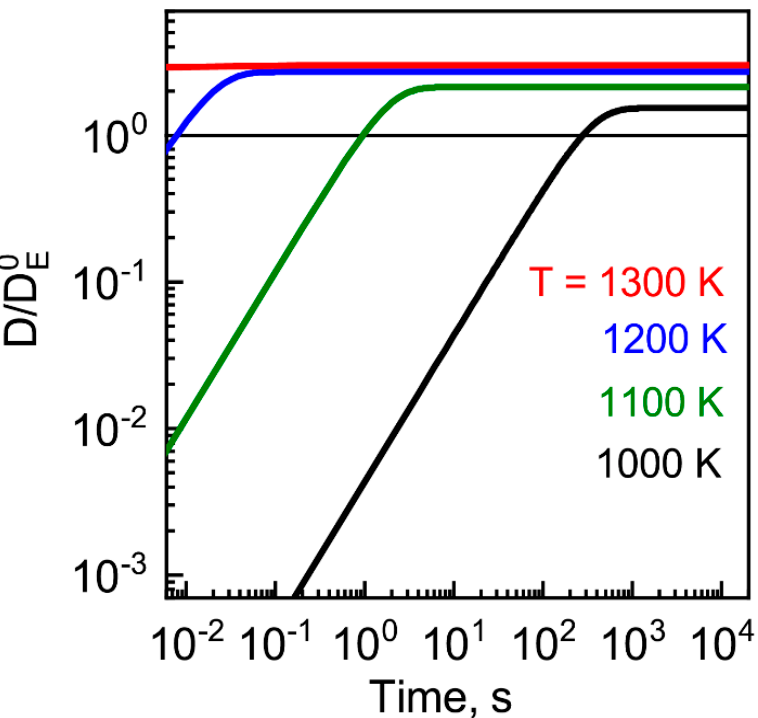
Figure 7. Dynamics of QW material diffusivity factor D vs. temperature calculated for a QW with a flat band structure. The diffusivity factor is normalized to its value D 0 , determined by the equilibrium concentration of neutral vacancies.